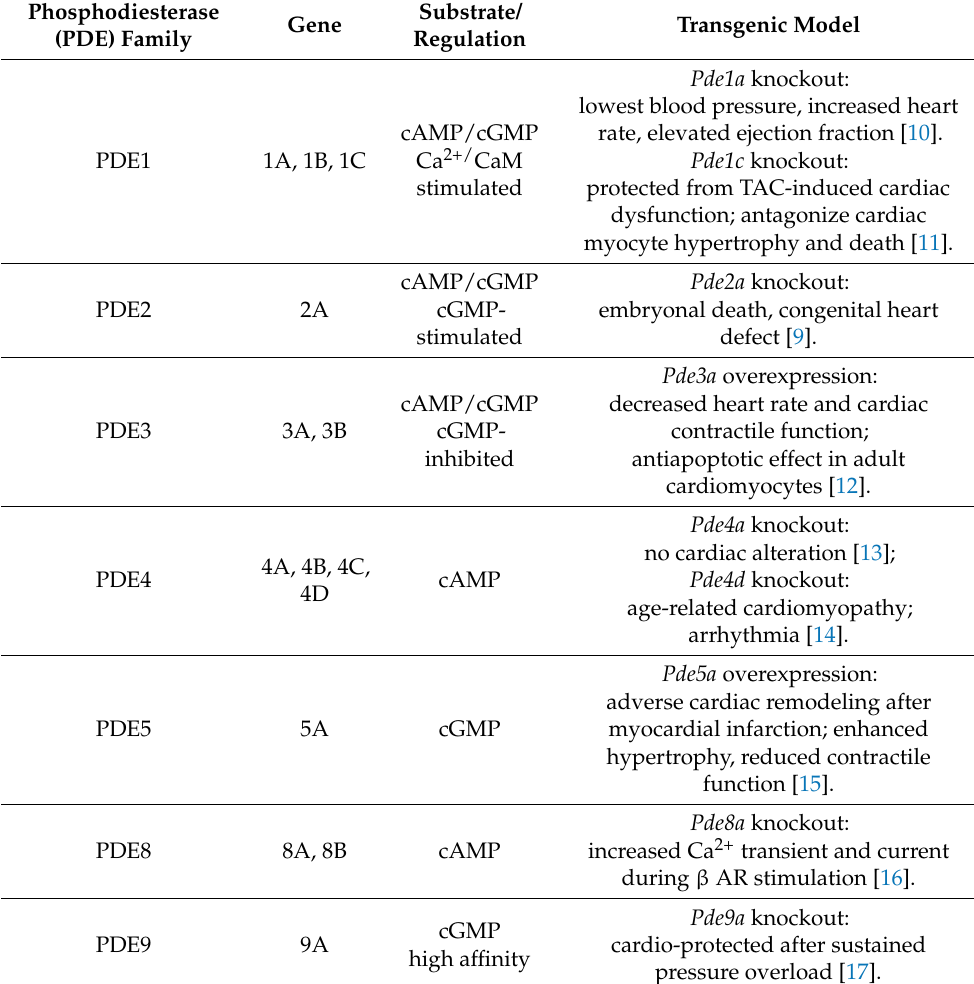
Table 1. Overview of PDE isoforms involved in cardiac